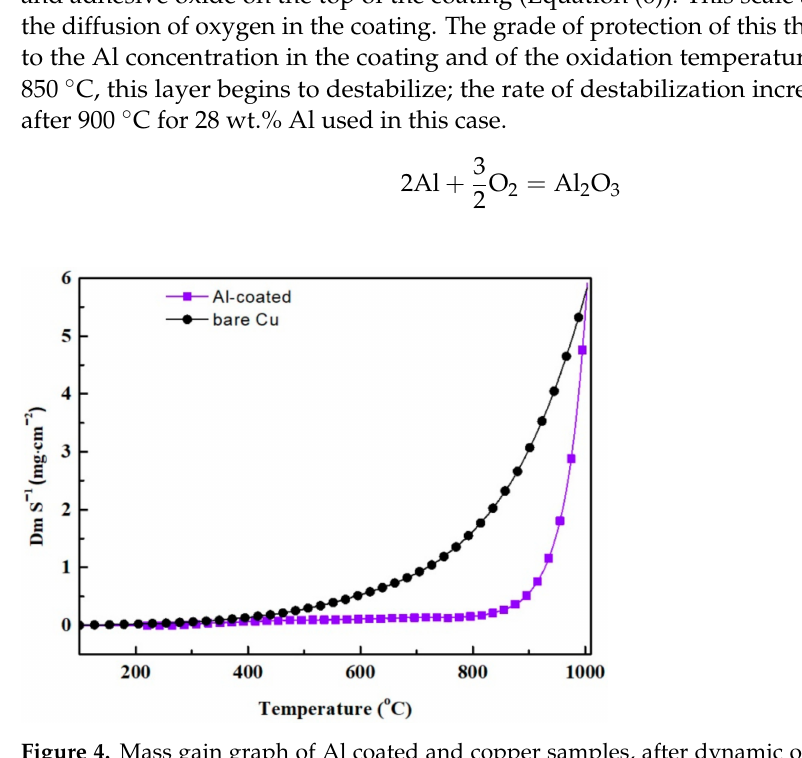
Figure 4. Mass gain graph of Al coated and copper samples, after dynamic oxidation from room temperature up to 1000 ◦